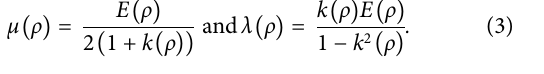
Frontiers in Bioengineering and Biotechnology |